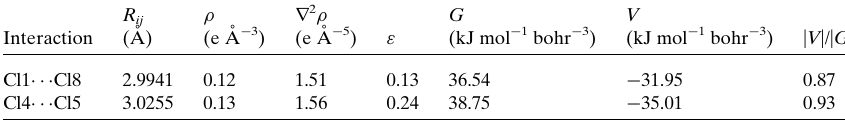
Table 2 Topological values of peri Cl (cid:2)(cid:2)(cid:2) Cl interactions at (3, (cid:6) 1) BCPs. R ij (A˚ Interaction